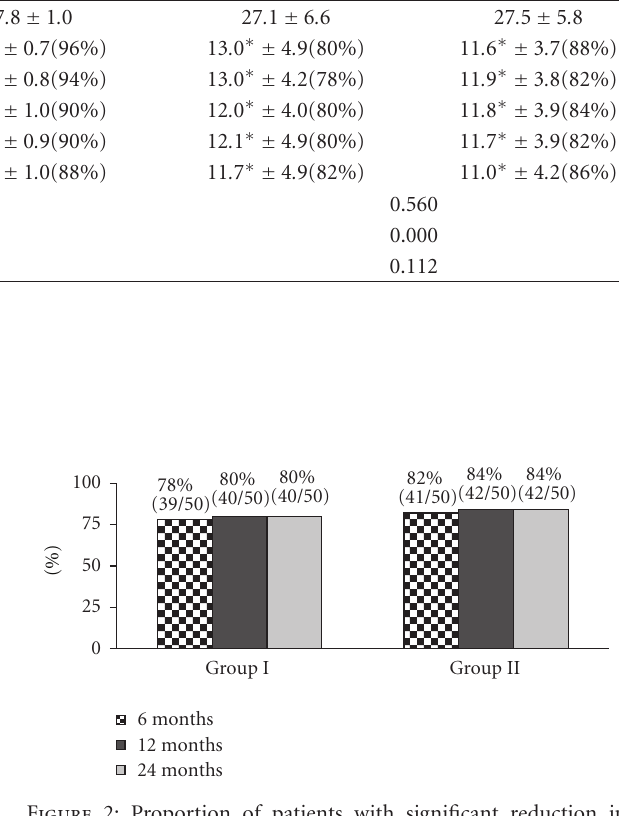
Figure 2: Proportion of patients with significant reduction in numeric rating score and Oswestry Disability Index ( ≥ 50% reduc- tion from